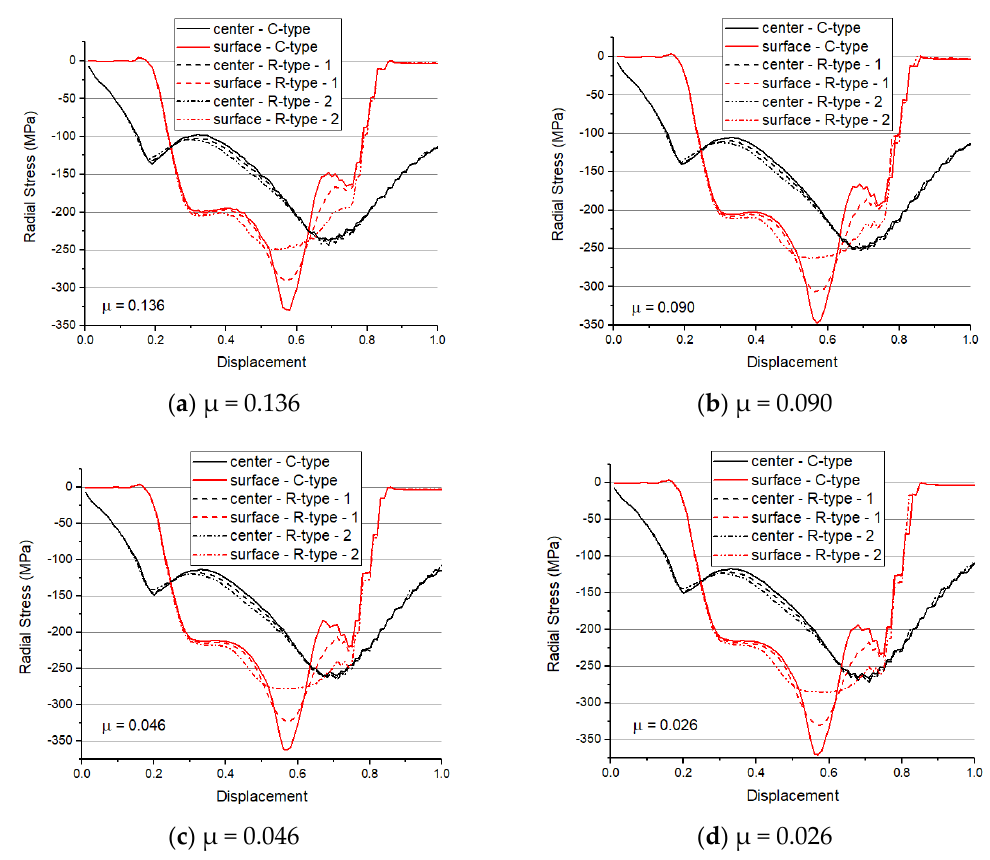
Figure 4. The calculated radial stress as a function of displacement, obtained by the finite element methods with different coefficients of friction.